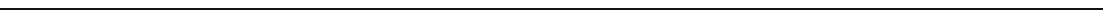
(See figure on previous page.) Fig. 8 Oat-like rice phenotypes and statistics of OsMADS1 Olr - overexpressing transgenic plants. a Grain shape and phenotypes of OsMADS1 Olr - overexpressing plants (OE-2 and OE-10) with similar Oat-like rice phenotypes in comparison with grains of the wild-type plant (NIP). Arrowheads indicate conjugated twin brown rice. b Relative expression of the OsMADS1 in 12 DAF grains of wild-type and OsMADS1 Olr - overexpressing plants. c Seed setting rate of wild-type and OsMADS1 Olr - overexpressing plants. d-f Chromatogram of cDNA fragments spanning the mutation site in OsMADS1 Olr or the corresponding wild-type site in OsMADS1 from RT-PCR amplification from NIP ( d ), OE-2 ( e ) and OE-10 ( f ) with a designed OsMADS1 -RT primer pair (Additional file 1: Table S5). Red arrowheads indicate the signal peak of A at the mutation site in OsMADS1 Olr cDNA derived from Oat-like rice, and blue arrowheads indicate the signal peak of G at the corresponding wild-type site in OsMADS1 cDNA derived from NIP. g Comparison of grain length, grain width, grain thickness, brown rice length, brown rice width, brown rice thickness, lemma length, palea length, lemma width, and palea width between wild-type and OsMADS1 Olr - overexpressing plants. h-k Comparison of grain length-to-width ratio ( h ), brown rice length-to-width ratio ( i ), 1000-grain weigh ( j ) and 1000-brown rice weight ( k ) between wild-type and OsMADS1 Olr - overexpressing plants. Bar: ( a ) 5 mm. Data presented are mean values ± SDs [ n = 3 replicates in b , j and k ; n = 12 replicates in c ; n = 50 in g-i .]. Student ’ s t -test: * p < 0.05, ** p < 0.01, *** p <